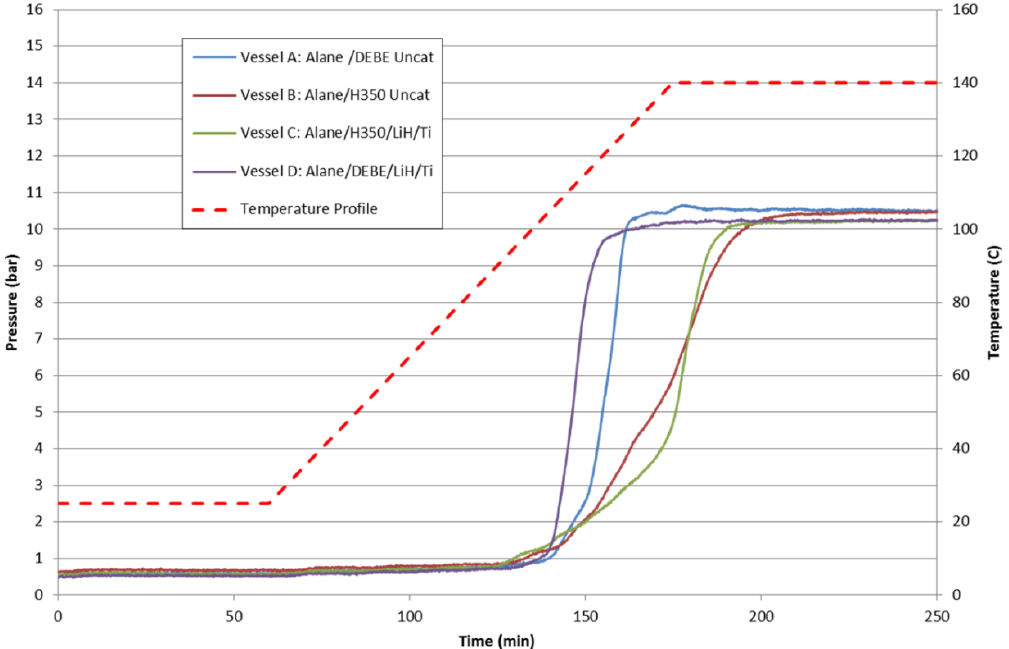
Figure 18. Batch reactor results of 20 wt% alane slurries for alane/DEBE uncatalyzed (blue), alane/DEBE catalyzed with LiH/Ti (purple), alane/Julabo H350 uncatalyzed (red), and alane/Julabo H350 catalyzed with LiH/Ti (green).